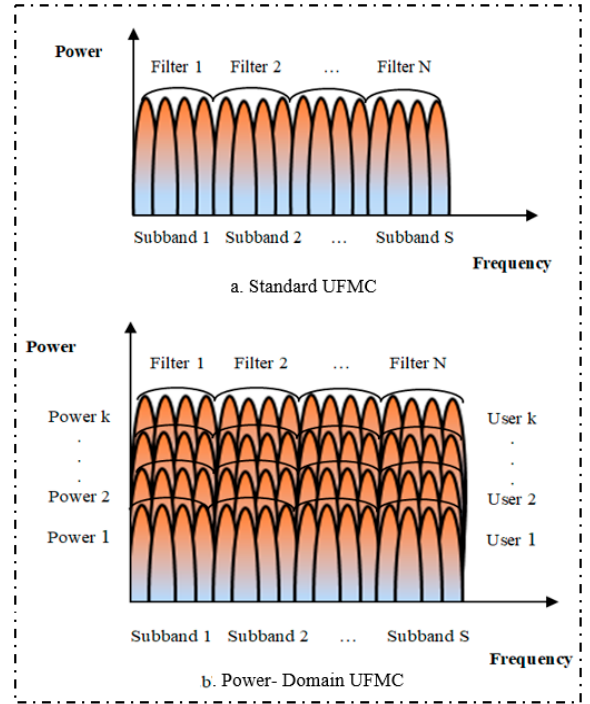
Figure 1. The universal filtered multi-carriers (UFMC) waveform vs. the power-domain UFMC waveform.